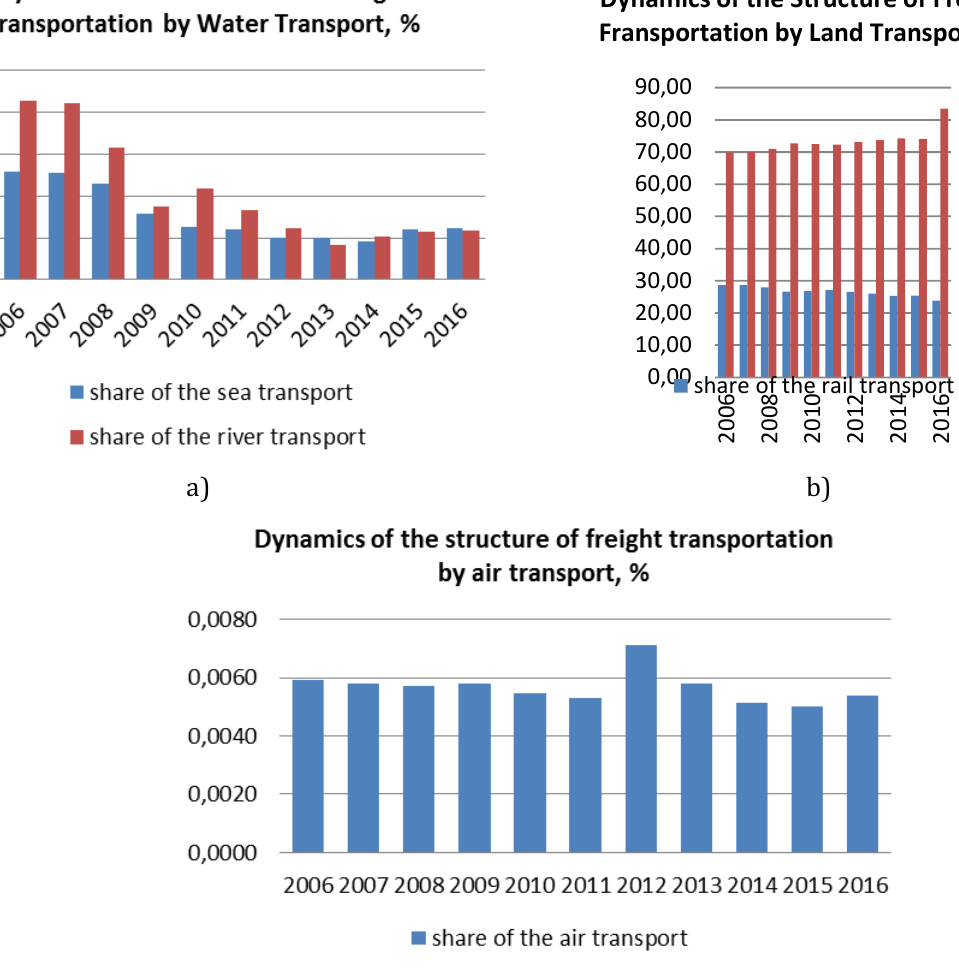
Fig. 3. Dynamics of changes in the structure of freight traffic by mode of transport for 10